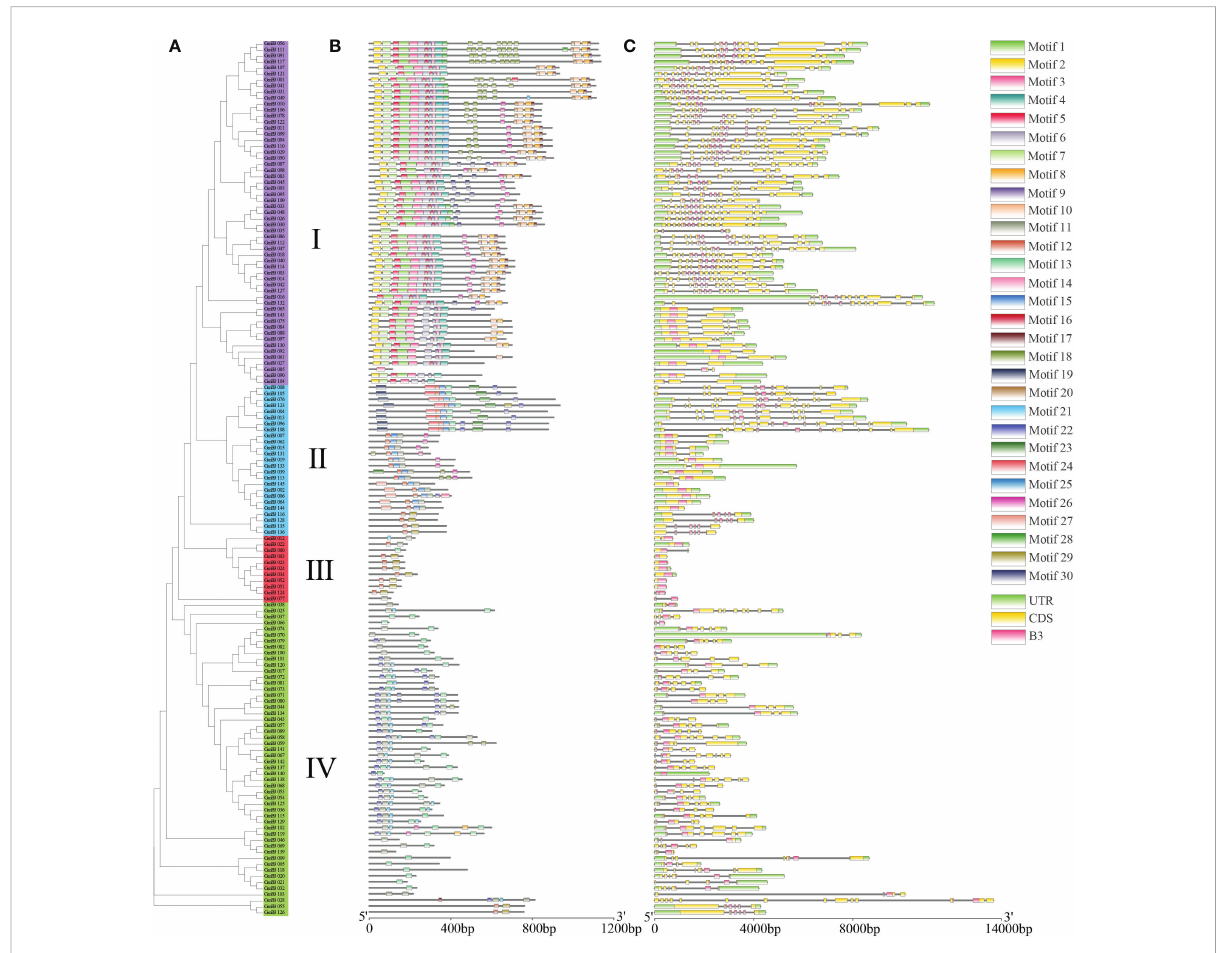
FIGURE 6 Gene structure and conserved motifs in GmB3 genes. (A) The phylogenetic tree of GmB3s protein. (B) The motif composition of GmB3 proteins. Different colors represented different motifs. (C) Exon-intron structure and conserved domain of GmB3